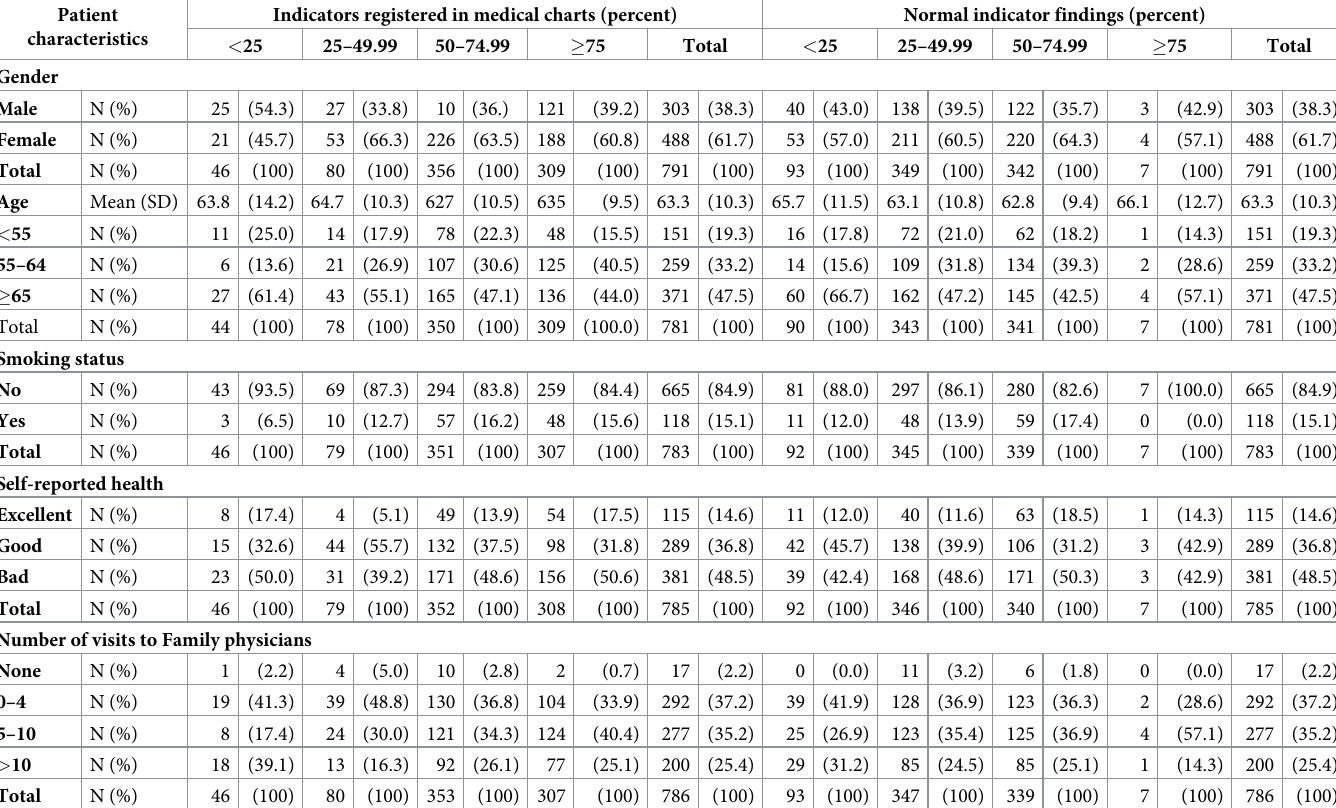
Table 2. The relationship between patient characteristics and hypertension guideline